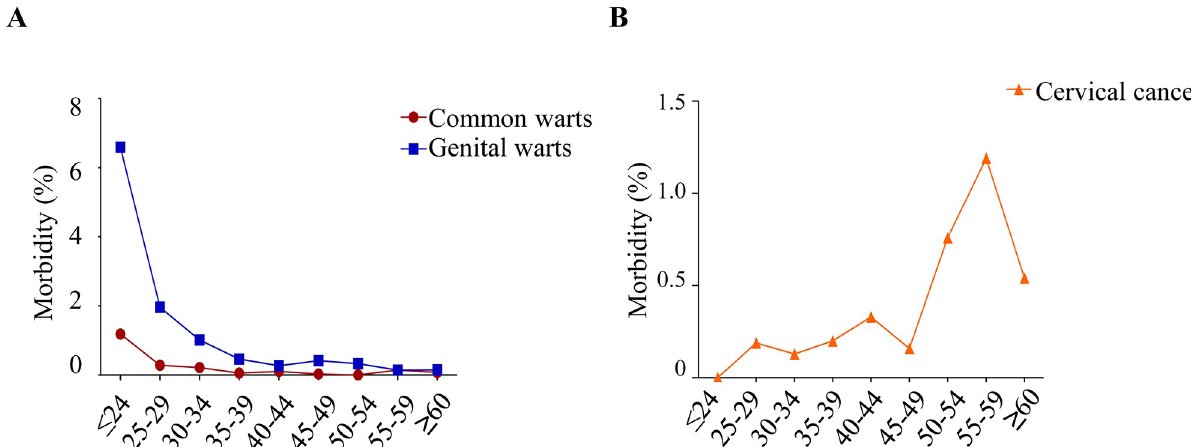
Fig 2. Overall age-related morbidity among women. (A)The morbidity of common warts and genital warts according to age. (B) The morbidity of cervical cancer according to age.